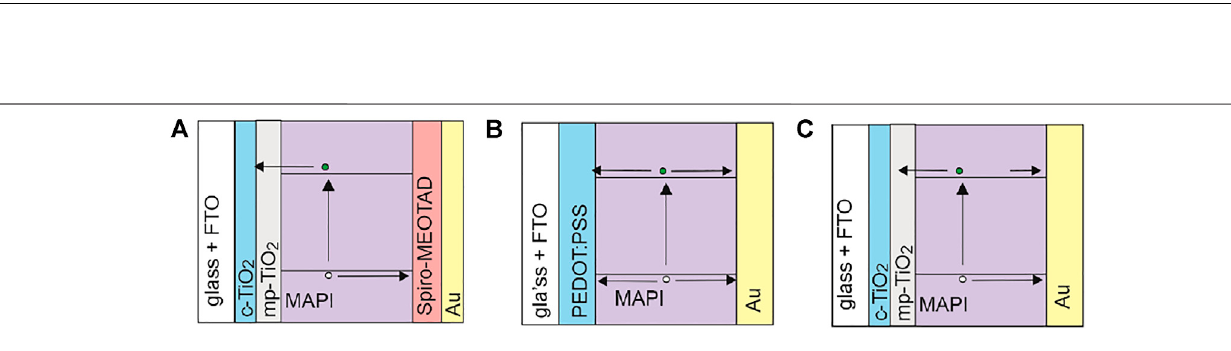
FIGURE 4 | Diagrams that show the TiO 2 and gold electrode polarization and direction of ion migration under a negative respectively, in MHP.